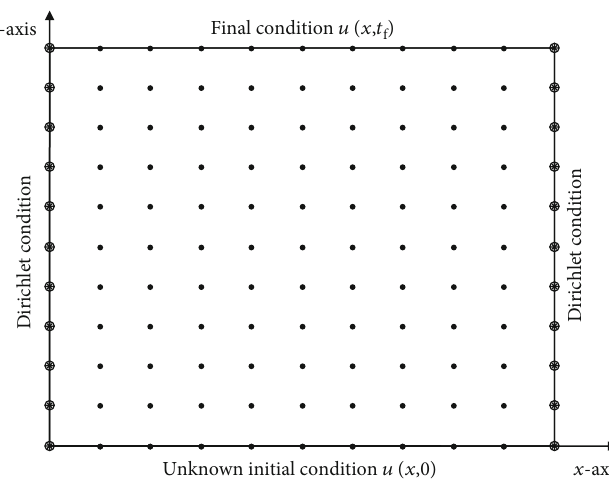
Figure 3: Domain and boundary conditions for the